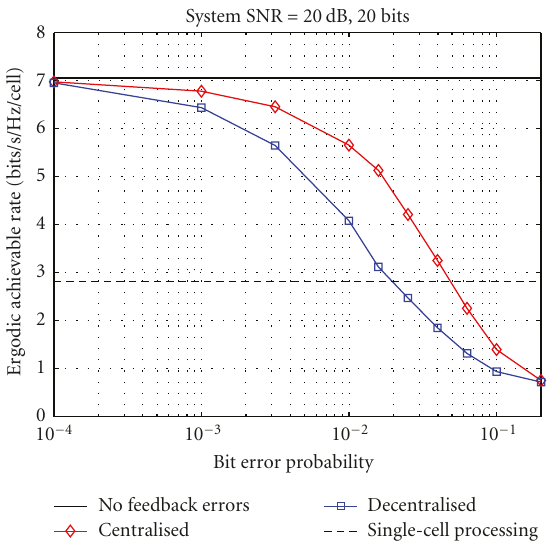
Figure 8: A plot of the ergodic achievable rate as a function of the bit error probability P e for both the decentralised and the centralised frameworks, when System SNR = 20 dB and 20bits are employed for quantization. In the decentralised case the CSI is fed back through 3 independent radio